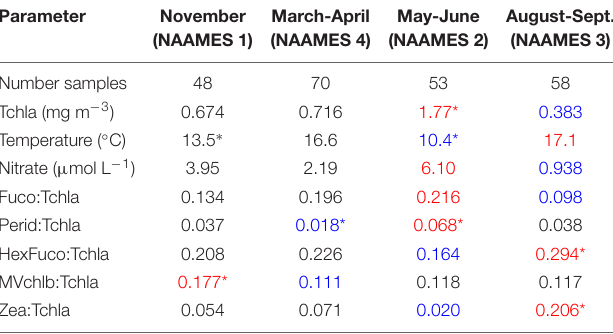
TABLE 1 | Summary of environmental and ecological variables for surface samples on NAAMES 1-4.